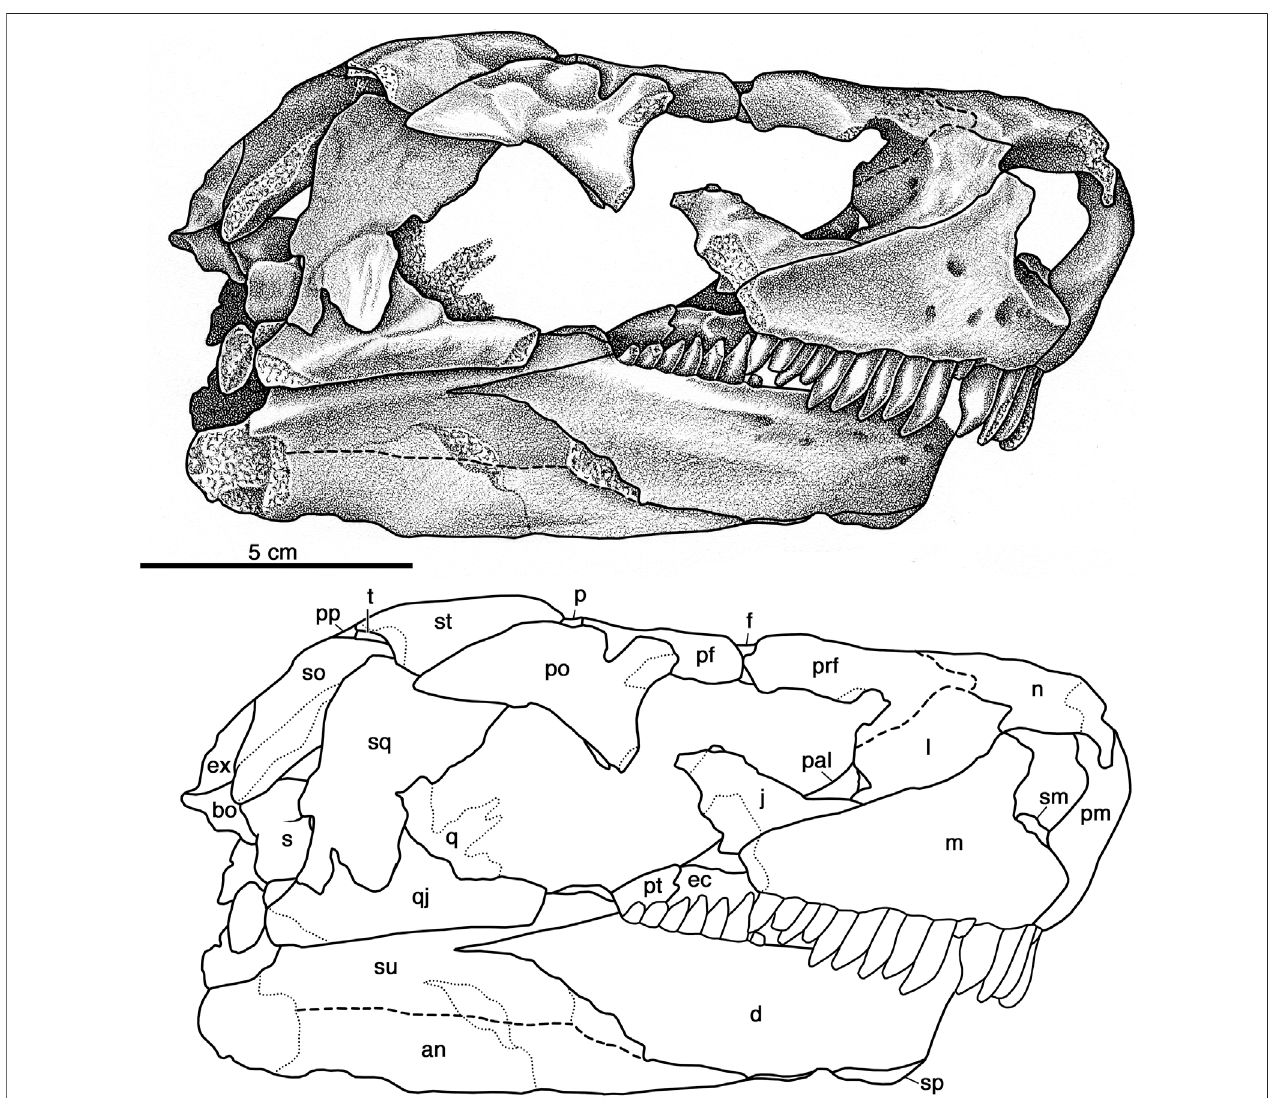
FIGURE 6 | Cotylorhynchus romeri , OMNH 04329, referred specimen. Skull in right lateral view. Abbreviations used in Panel 6, Figures 7 – 9 : an, angular; ar, articular; bo, basioccipital; co, coronoid; d, dentary; ec, ectopterygoid; ex, exoccipital; f, frontal; j, jugal; l, lacrimal; lj, lower jaw; m, maxilla; n, nasal; o, opisthotic; p, parietal; pp, postparietal; pal, palatine; pf, postfrontal; pm, premaxilla; po, postorbital; pp, postparietal; pra, prearticular; prf, prefrontal; ps, parasphenoid; pt, pterygoid; q,quadrate;qj,quadratojugal;s,stapes;sm,septomaxilla;so,supraoccipital;sp,splenial;sph,sphenethmoid;sq,squamosal;st,supratemporal;su,surangular;t, tabular; v,